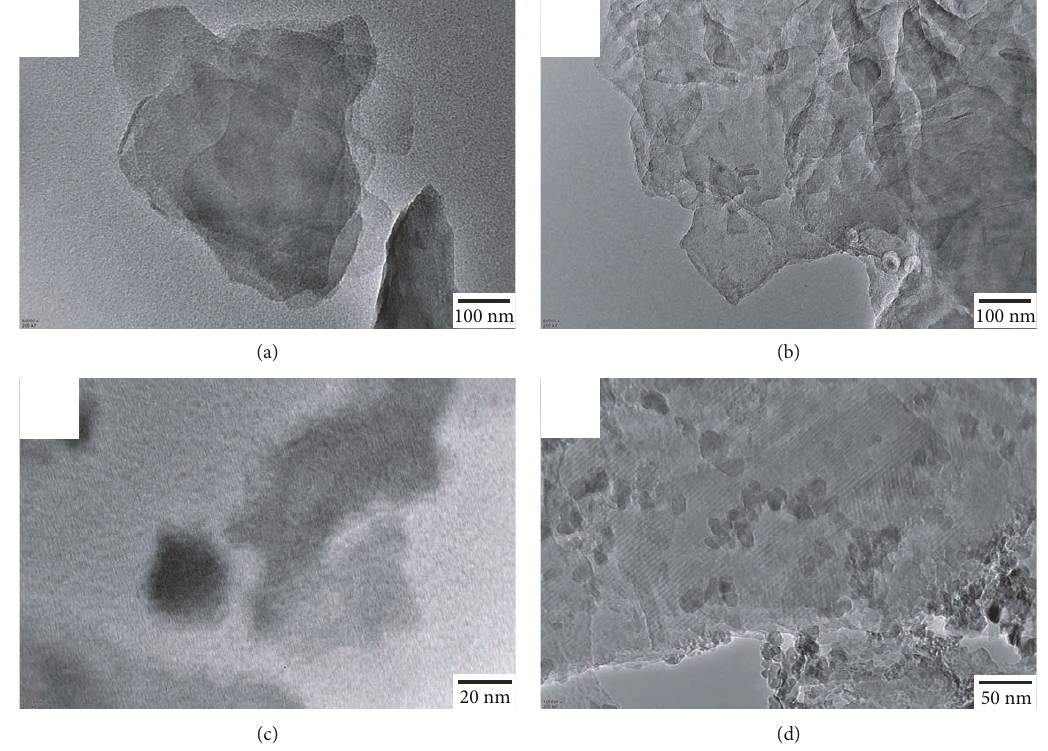
Figure 6: TEM images of all samples ((a) MT; (b) T-400; (c) T-H; (d) T-H-400).